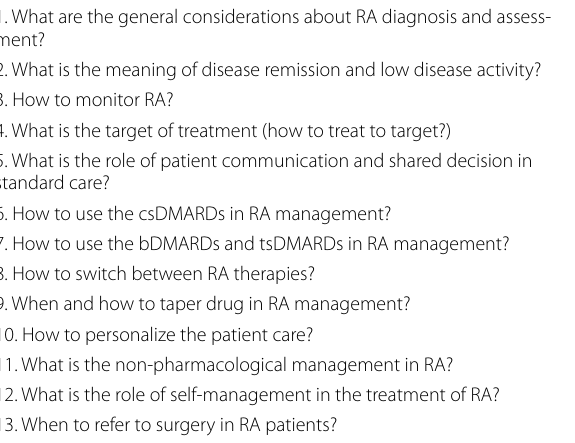
Table 4 Key clinical questions used to develop the